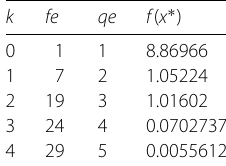
Table 5 Numerical results of Example